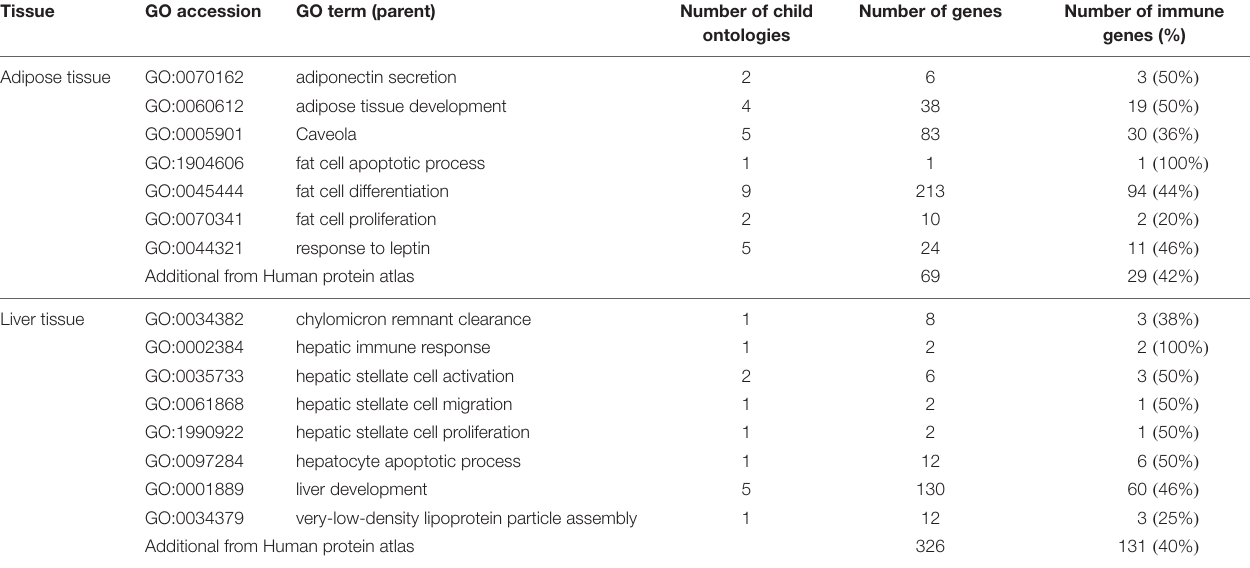
Number of genes Number of immune ontologies genes (%)